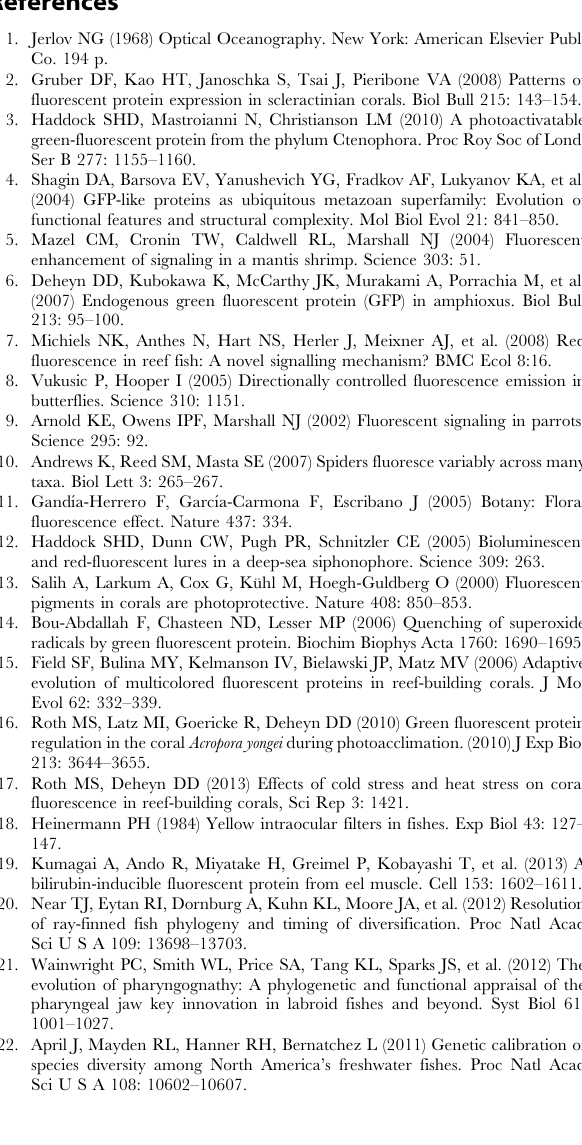
Species (column 3). Columns 4 (red) and 5 (green) contain filled circles corresponding to the observed color of fluoresced light. Column 6 gives AMNH catalog numbers. Taxa indicated with an * are not included in the phylogenetic reconstruction (Fig. 2). Table S2 GenBank accession numbers and sources for DNA sequences utilized in the phylogenetic reconstruction shown in Fig. 2 and Fig. S1. (PDF) Video S1 Supplementary video to accompany Fig. 5A showing a red fluorescing scorpionfish, Scorpaenopsis papuensis , perched on red fluorescing algae in its natural habitat. Video captured with a Red Epic video camera at night in the Solomon Islands. (MOV) Video S2 Supplementary video to accompany Fig. 5B showing a green fluorescing nemipterid (bream), Scolopsis bilineata , swimming near a green fluorescing Acropora sp. coralhead. Video captured with a Red Epic video camera at night in the Solomon Islands.